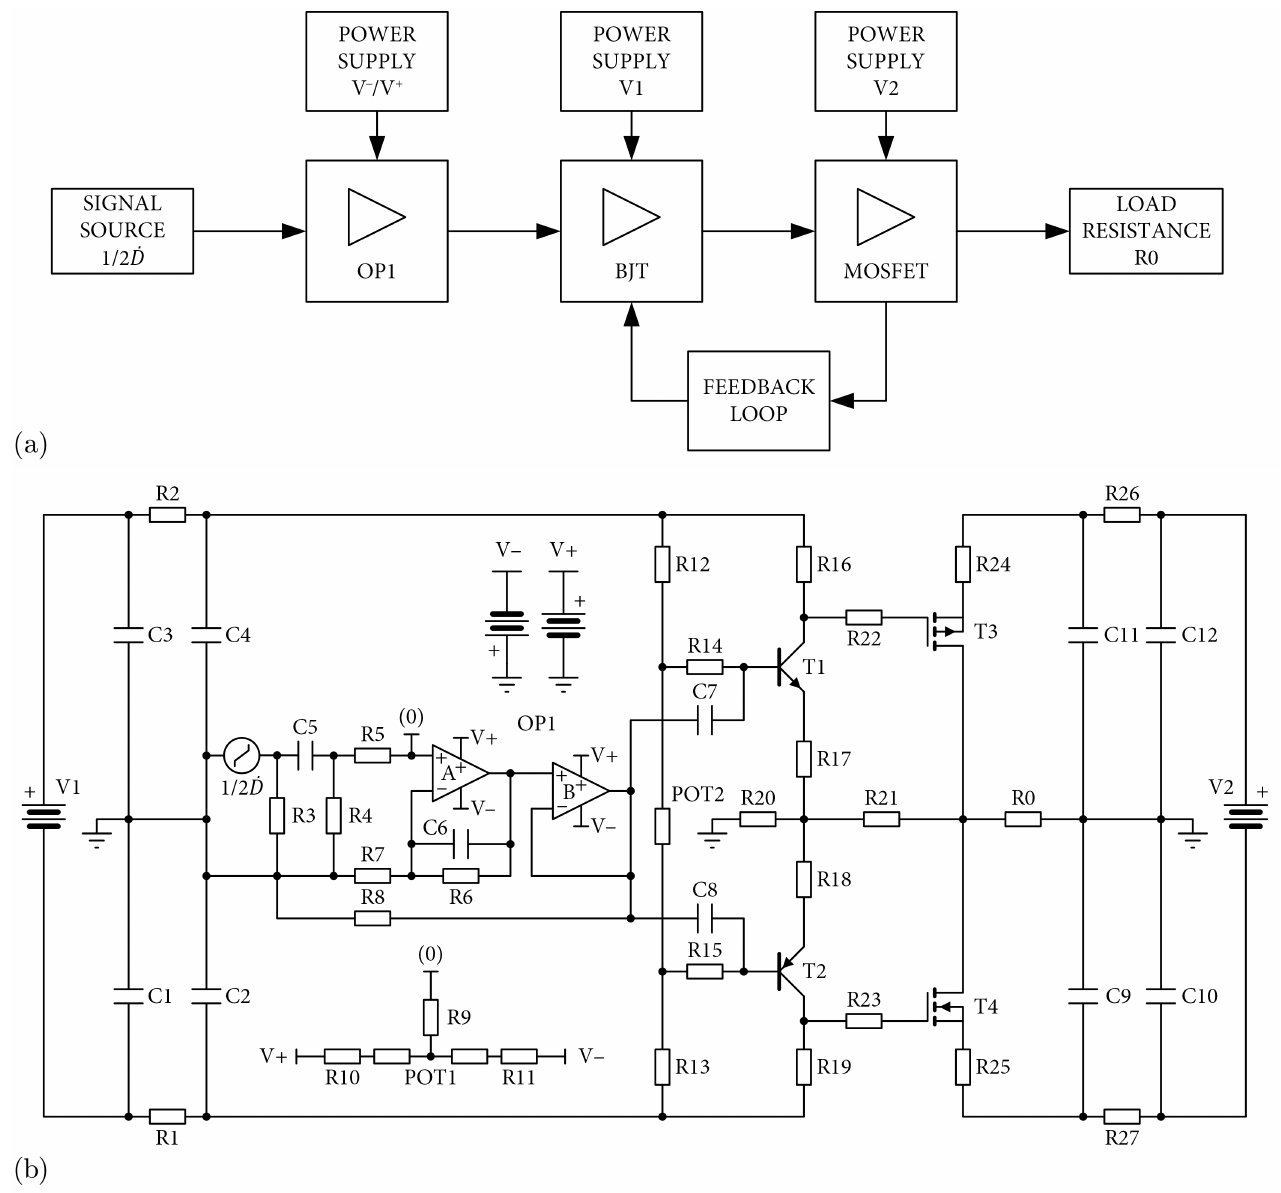
Figure 3. ( a ) Block scheme and ( b ) diagram of the designed LF semiconductor